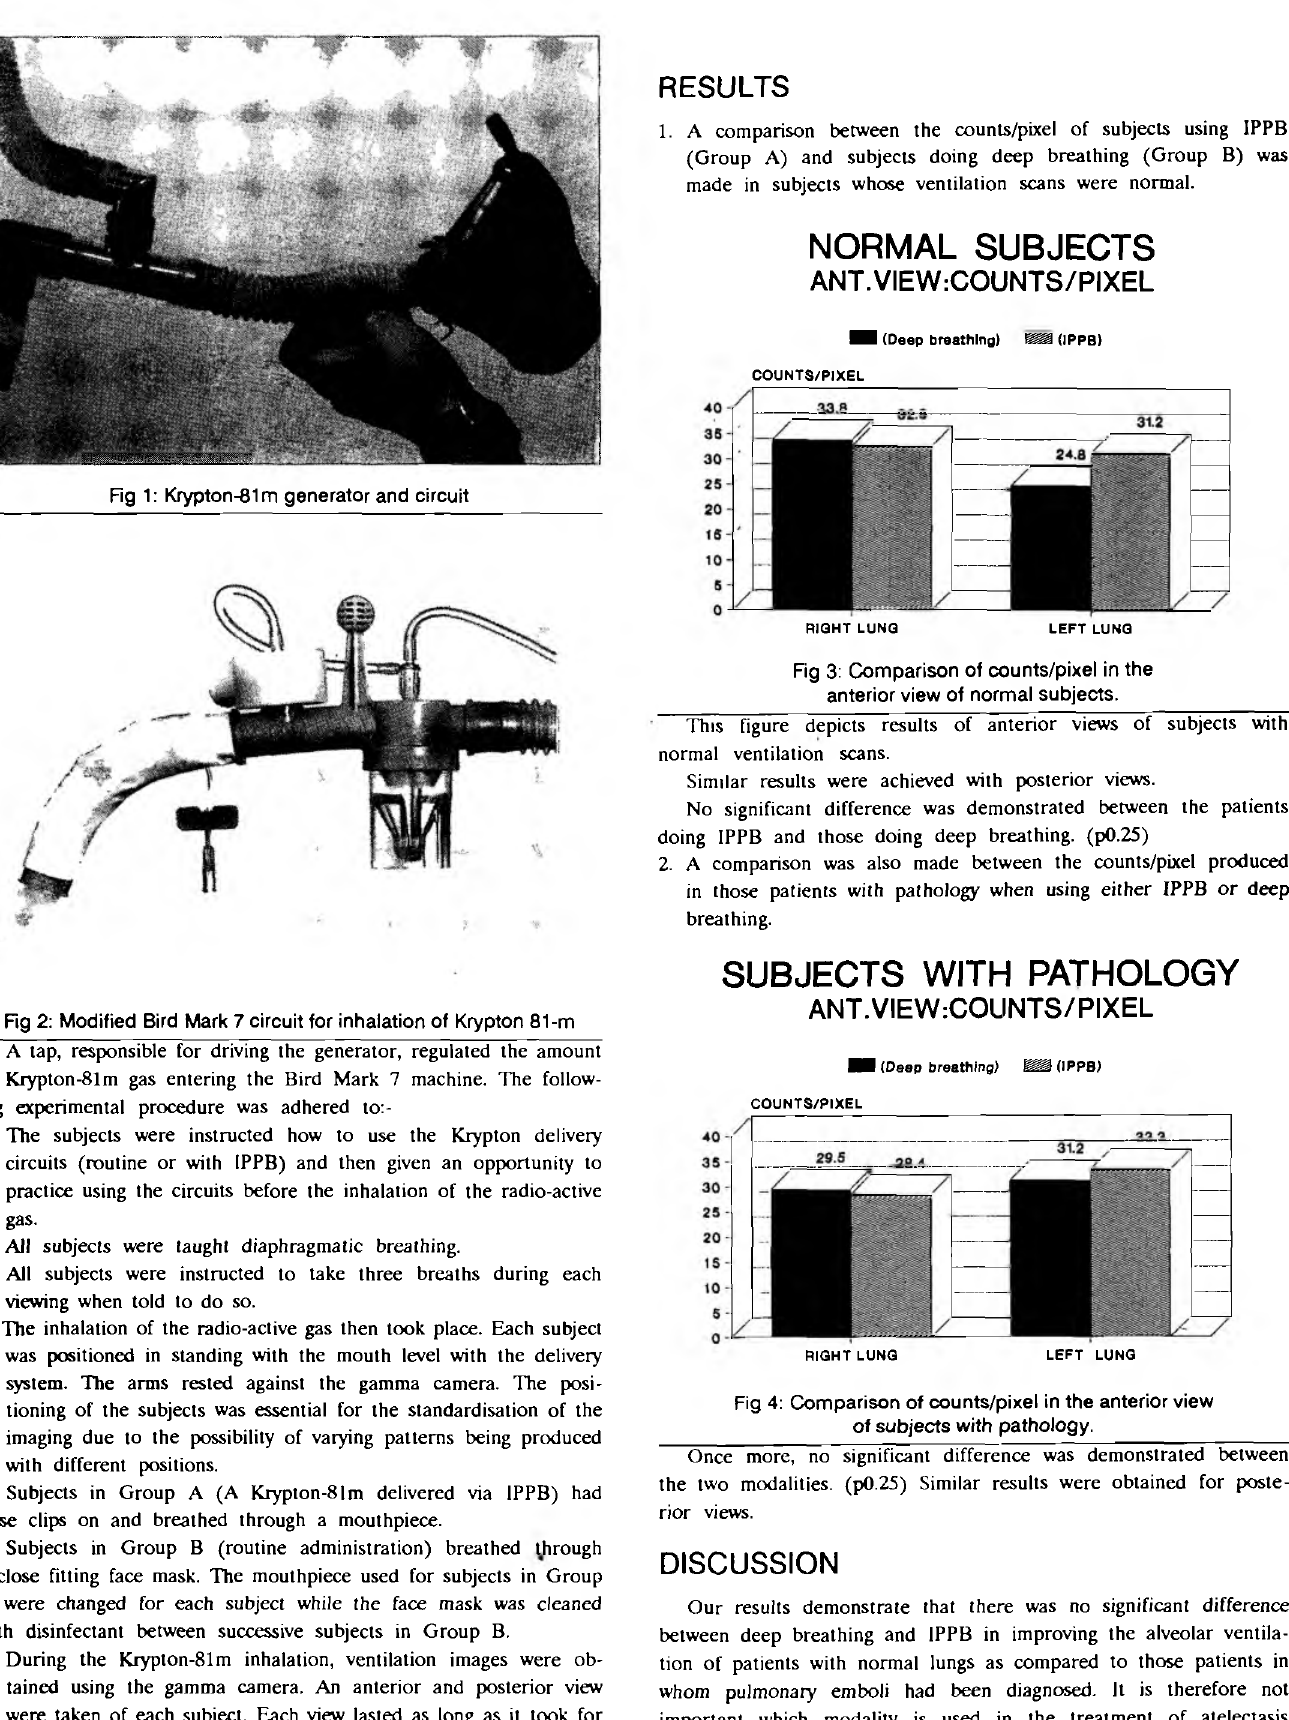
Fig 1: Krypton-81 m generator and circuit